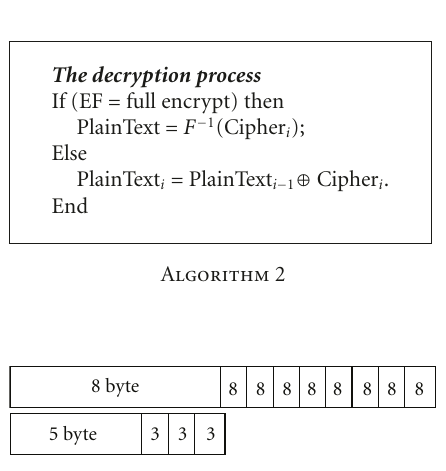
Figure 7: Rear padding in